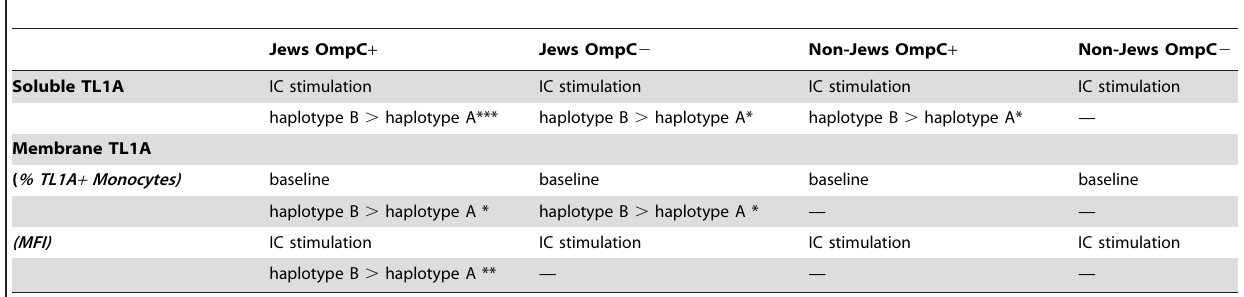
Table 3. Summary of significant differences for TL1A haplotypes A and B in CD patients sub-stratified into Jewish OmpC + /OmpC 2 and non-Jewish OmpC + /OmpC